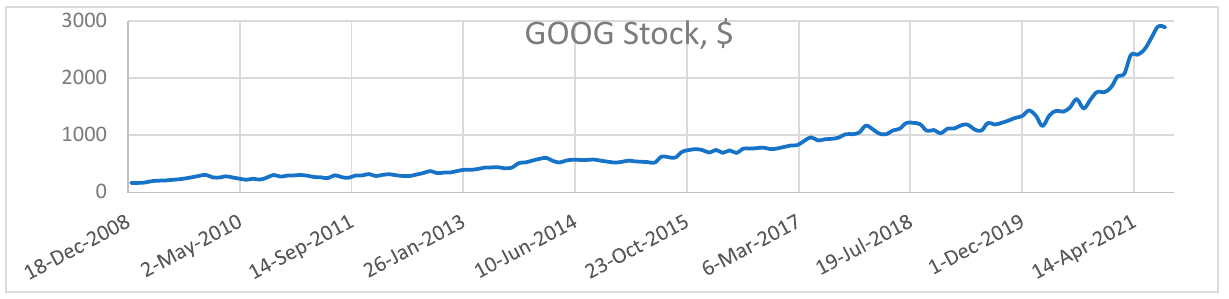
Figure 3. Google stock price analysis, USD.